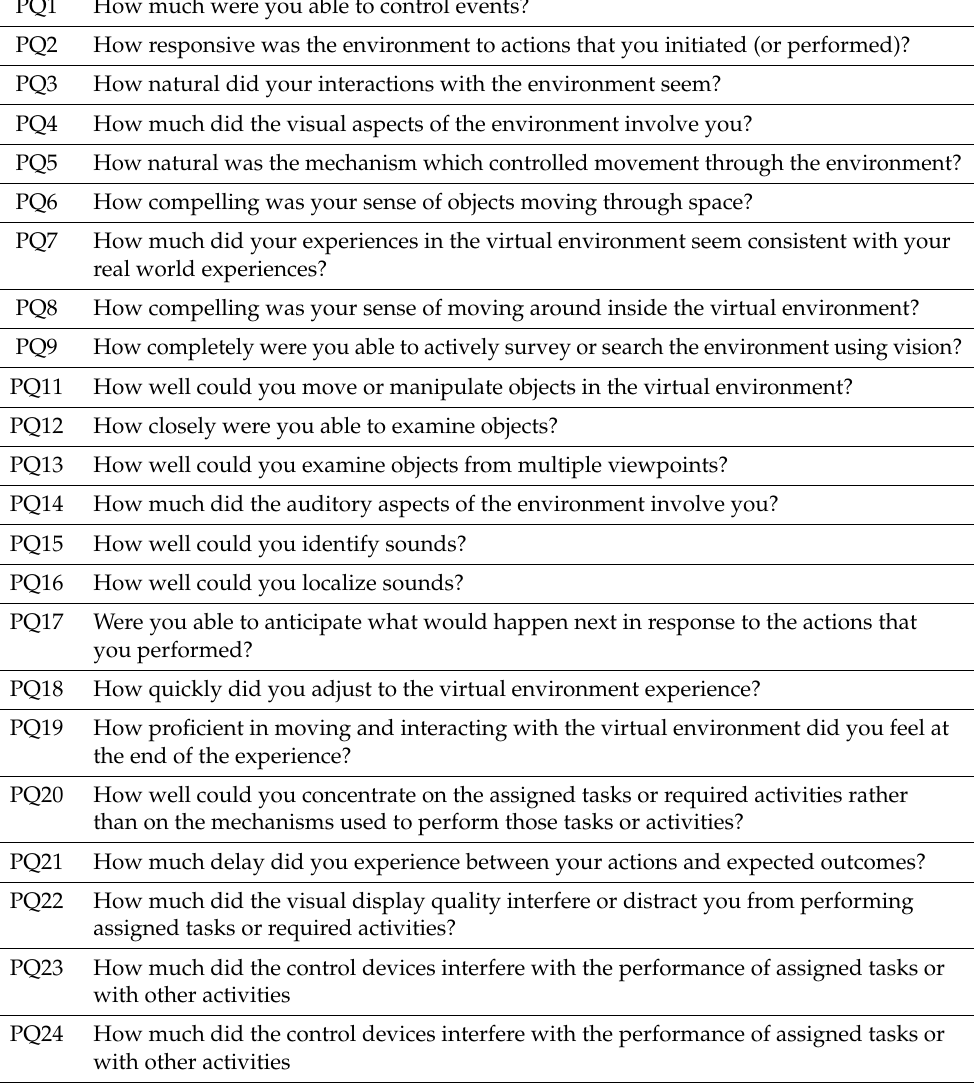
Table 1. Questions of the PQ questionnaire